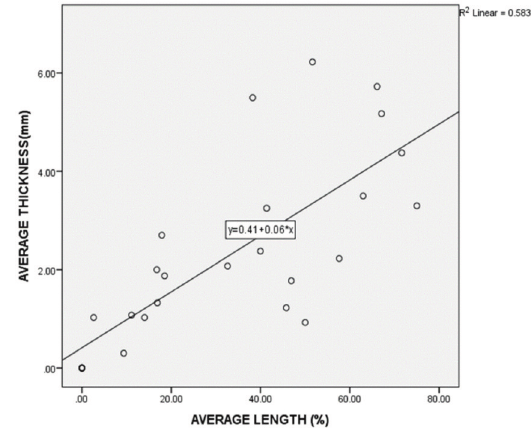
Correlation of EBBI Thickness and EBBI Length. EBBI Fig. 4: Thickness is significantly and positively correlate with EBBI Length (p<0.001) and it also explains about 58.3% of variability (r2 = 0.583). In this study, for each 1mm increase in EBBI thickness, on average, the length will increase by